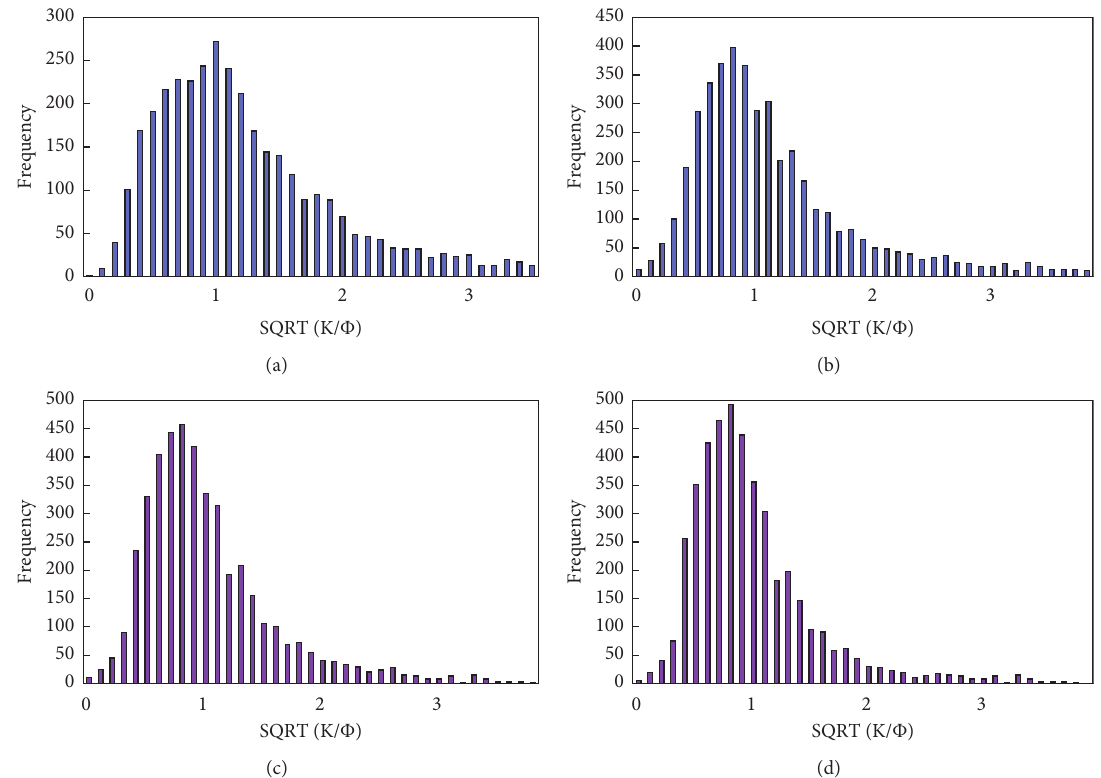
Figure 4: Frequency distribution of composite index of pore structure. (a) K 71 . (b) K 72 . (c) K 73 . (d) K 74 .